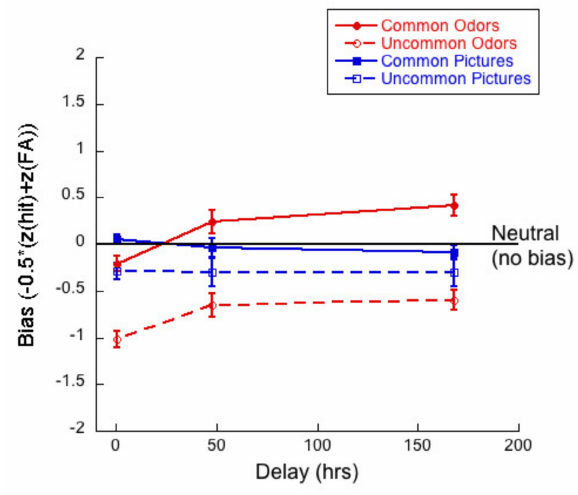
Figure 13. Bias as a function of delay for each of the four test conditions. Negative values reflect a “liberal” criterion (greater willingness to say